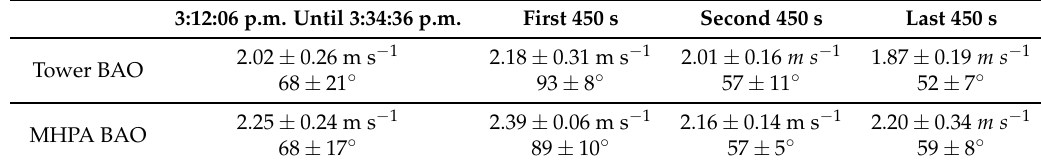
Table 2. Horizontal wind speed and wind direction at Boulder Atmospheric Observatory meteorological tower. Data at 100 m above ground level (AGL) in comparison with the multi-hole-probe algorithm (MHPA) for the flight on 8 August 2014 between 3:12:06 p.m. and 3:34:36 p.m. local time. Additionally, the data is divided into three intervals of 450 s each.